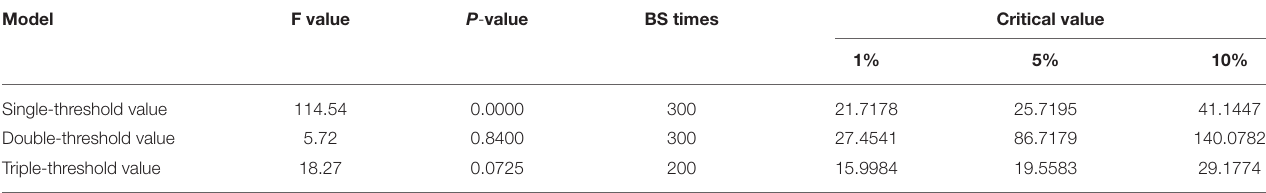
TABLE 8 | Panel threshold self–sampling model.